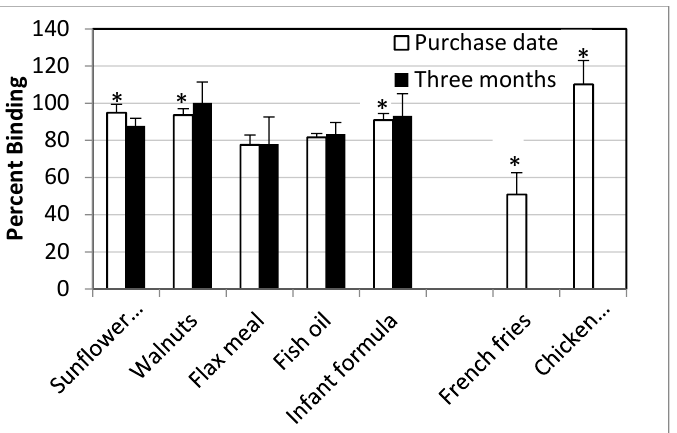
Figure 5. Percent PPAR γ binding by lipids extracted from foods. Means ± SEM of the PPAR γ binding of lipids extracted from various foods at a 1% concentration on the purchase date (white bars) and after 3-month storage (black bars) at room temperature were not significantly different. * Mean binding of French fries was significantly different than that of sunflower seeds, walnuts, infant formula and chicken nuggets.